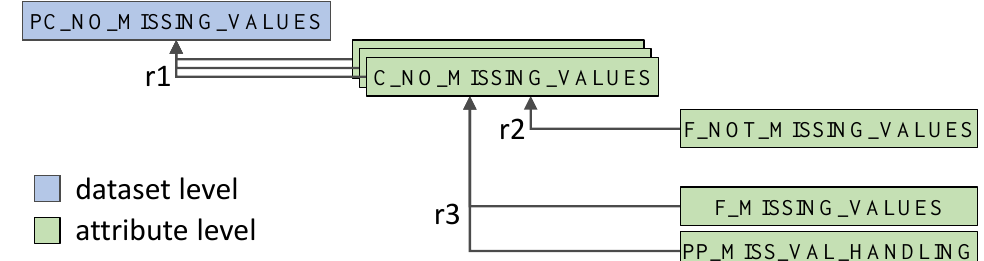
Figure 10. Hierarchical structure of the KB for the example of missing values.